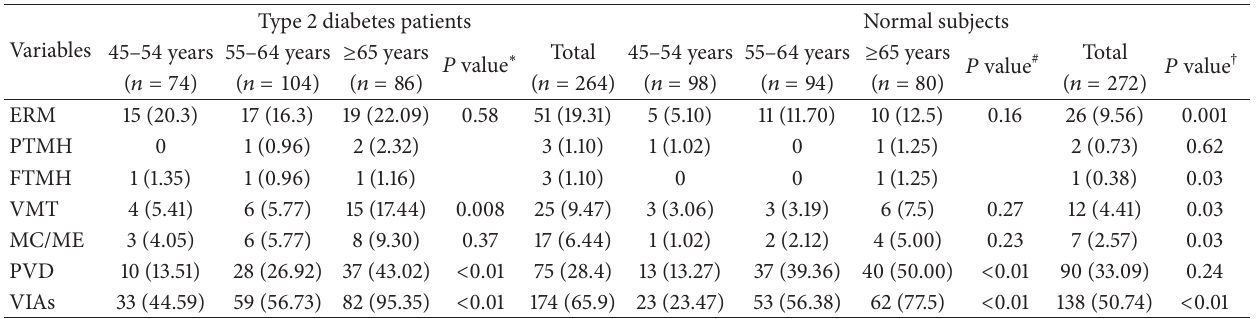
Table 3: The prevalence of VIAs within males in this study (number of eyes or %). Variables